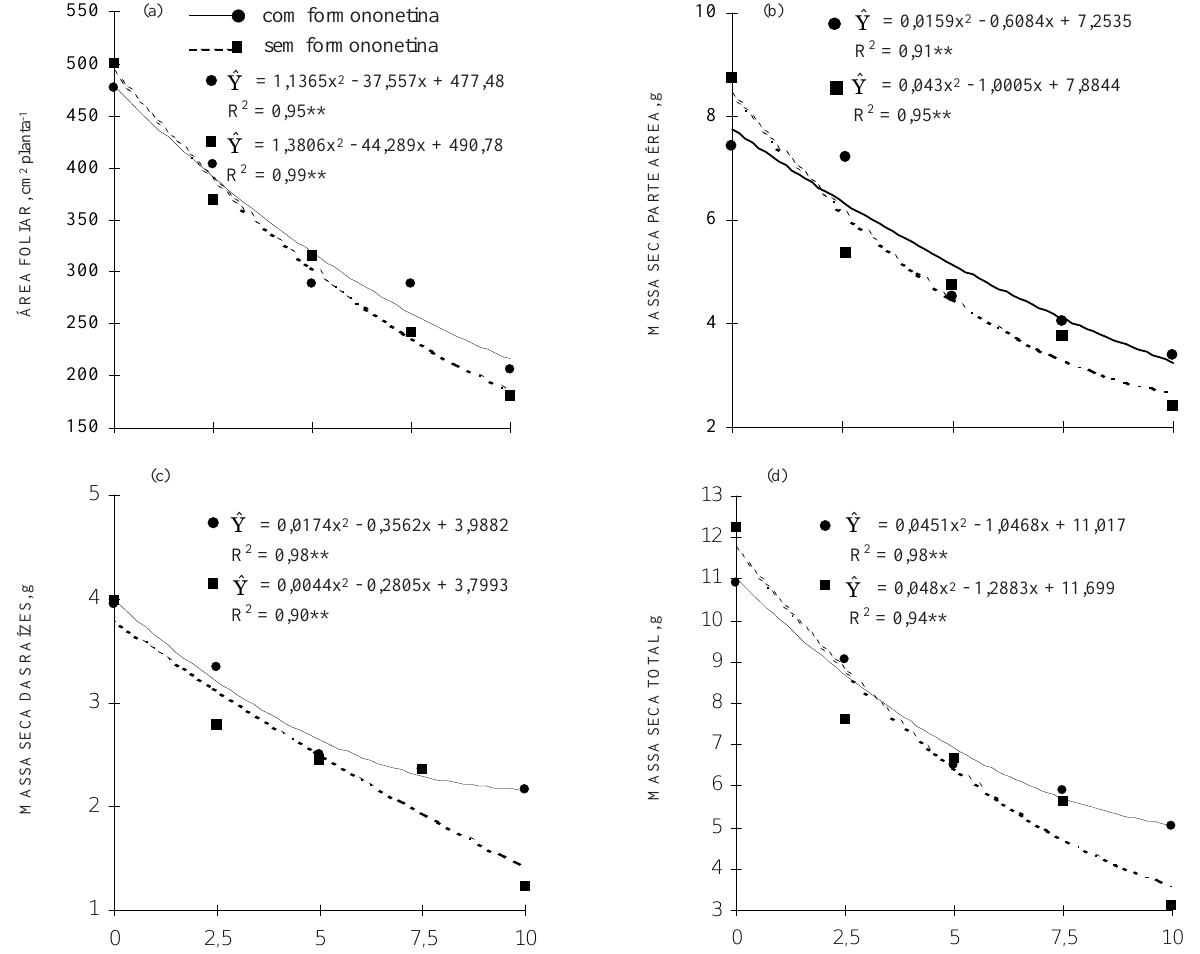
SOLO CONTAMINADO, % Figura 1. Crescimento do milho em função da proporção de solo contaminado com metais pesados e aplicação de formononetina no solo.